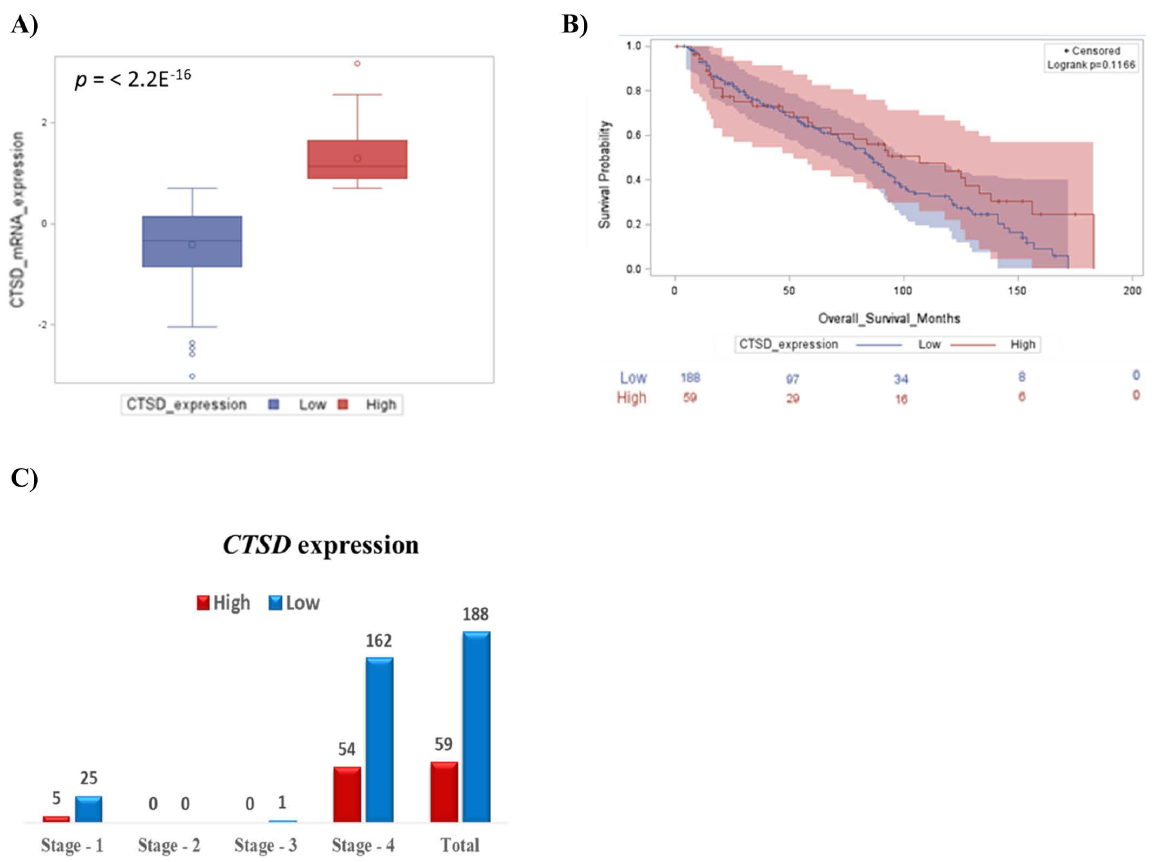
Figure 1. Neuroblastoma patients bearing high CTSD transcript level show a better prognosis. ( A ) Box-plot showing the distribution of CTSD expression. ( B ) Kaplan–Meier plot representing the overall survival of neuroblastoma patients according to CTSD expression levels (high and low). ( C ) Low expression of CTSD correlates with INSS Stage 4 in neuroblastoma